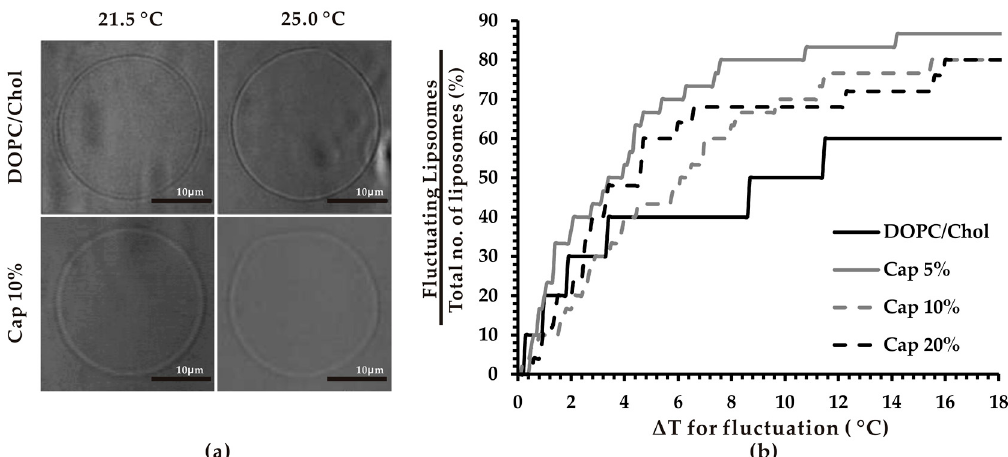
Figure 1. Thermosensitivity of capsaicin-containing vesicles. ( a ) Typical microscopic images of liposomes before and after fluctuation. DOPC/Chol liposomes (top) and DOPC/Chol/Cap (10% ( v / v )) liposomes (bottom) at 21.5 ◦ C and 25.0 ◦ C as initial and final temperature, respectively. ( b ) Fluctuation profile of liposomes. Temperature was increased from 21.5 to 40 ◦ C using a thermo-controller (tolerance ± 0.5 ◦ C). The number of liposomes and the temperature at which the liposomes started to fluctuate was noted, expressed as a percentage of fluctuating liposomes over total number of liposomes, at the given temperature change ( n = 30).